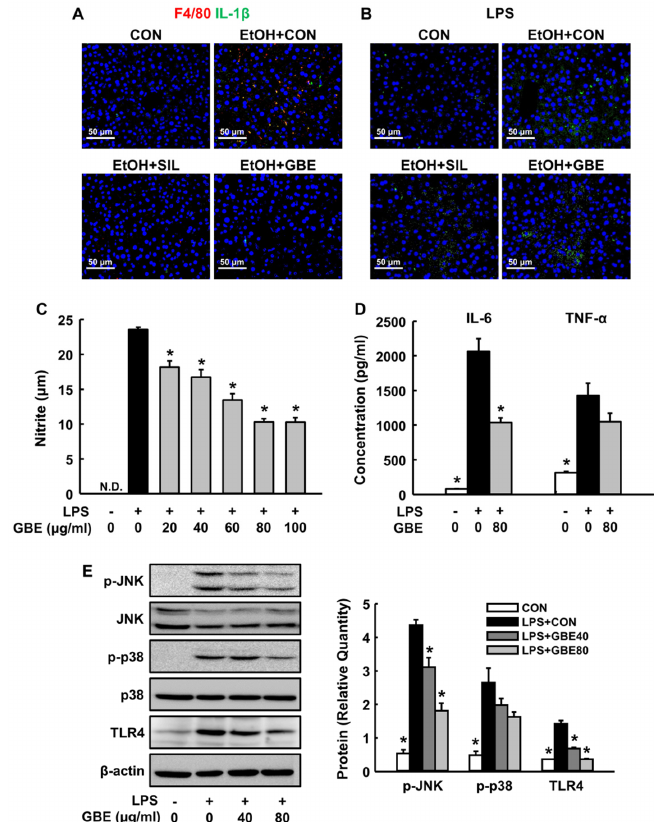
Figure 3. Effects of GBE on alcohol-induced Kupffer cells activation and lipopolysaccharide (LPS)-stimulated inflammatory response in macrophages. Representative immunohistochemical staining of liver for ( A ) F4/80 (red, Kupffer cells marker) and interleukin-1 β (green) and ( B ) lipopolysaccharide (green). The released levels of ( C ) nitrite, ( D ) interleukin-6, and tumor necrosis factor- α from lipopolysaccharide-stimulated RAW 264.7 macrophage cells. ( E ) Western blot of phospho-c-Jun N-terminal kinase (p-JNK), total JNK, p-p38, total p38 and toll-like receptor 4 (TLR4) from macrophage cell extracts with quantitative data. CON, control; SIL, silymarin; GBE, water extract of G. bimaculatus . Data are shown as means ± SEM ( n = 4 for A–C and n = 6 for D–F). * p < 0.05 vs. EtOH control group or LPS control